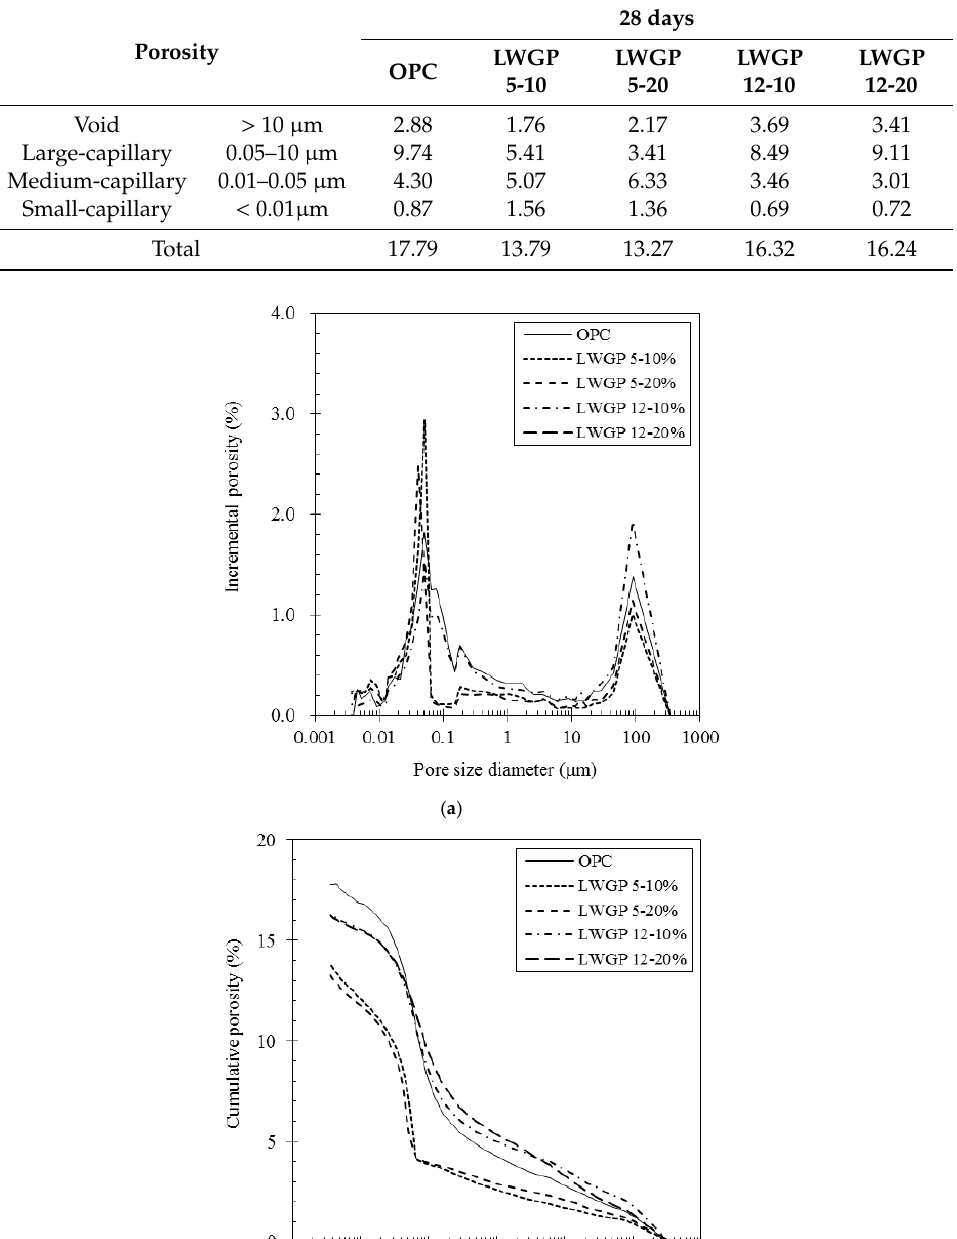
Table 4. Comparison of porosity by the pore size of LWGP concrete specimen at 28 days.